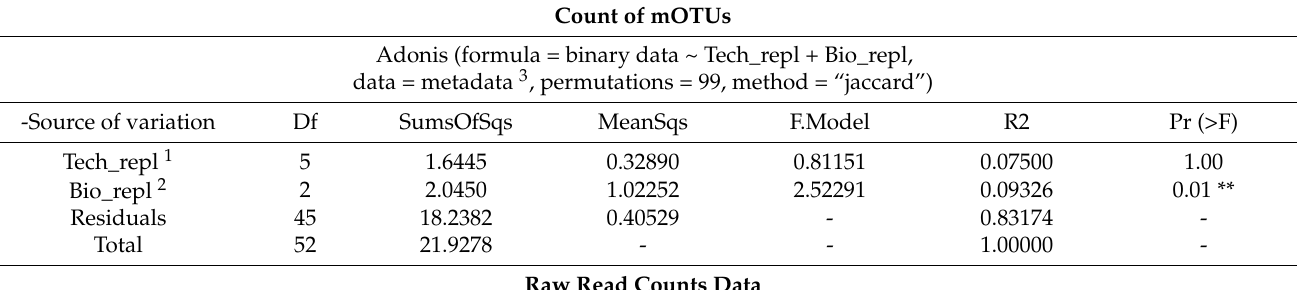
Table A1. PERMANOVA test analysis variation within technical and biological replicates. Count of